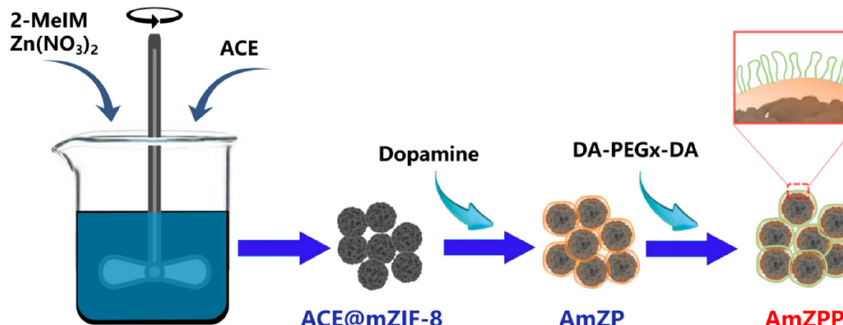
Figure 1. The synthesis procedure of AmZPP x .